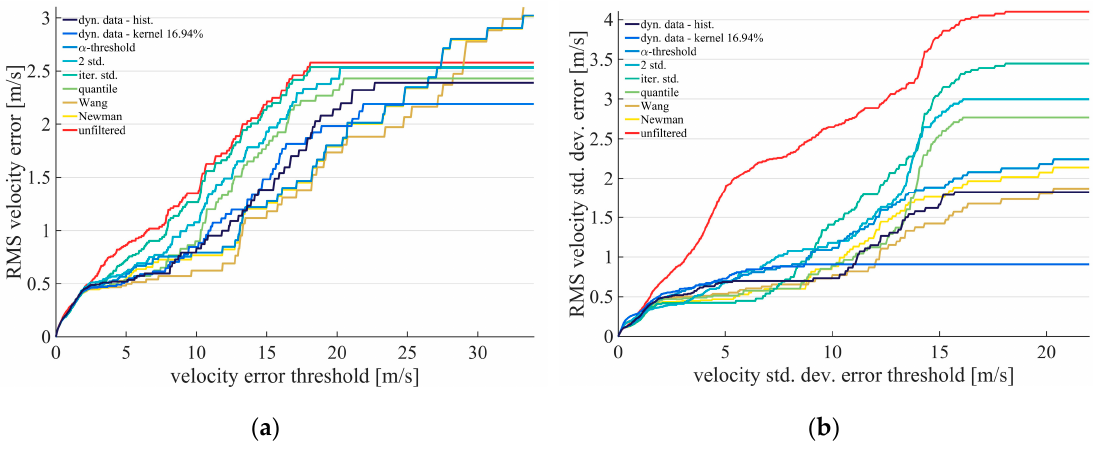
Figure 14. Histogram in double logarithmic scaling with exponential increasing bin width of the ( a ) absolute average velocity error and ( b ) the absolute velocity standard deviation error. Vertical dashed lines indicate the centre of a fitted Gaussian curve.